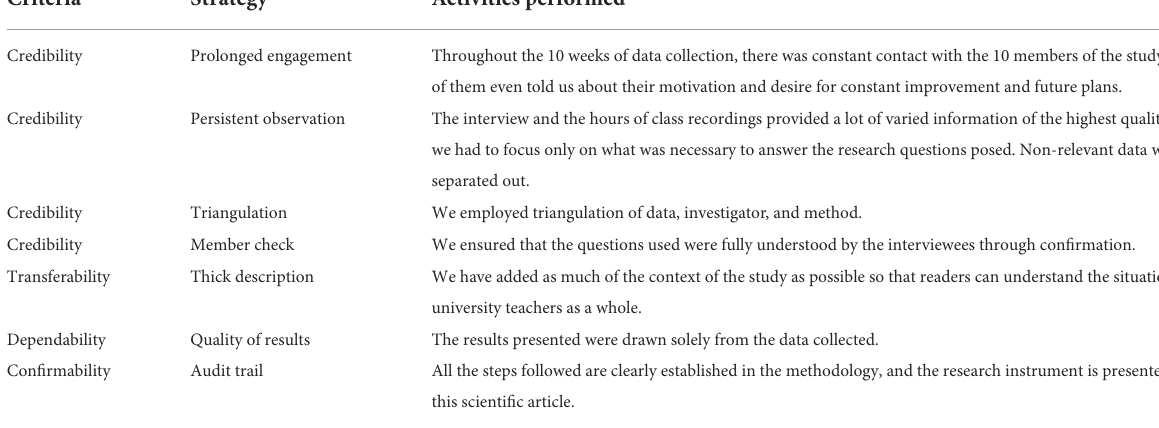
TABLE 5 Answers on information competence for each of the subjects